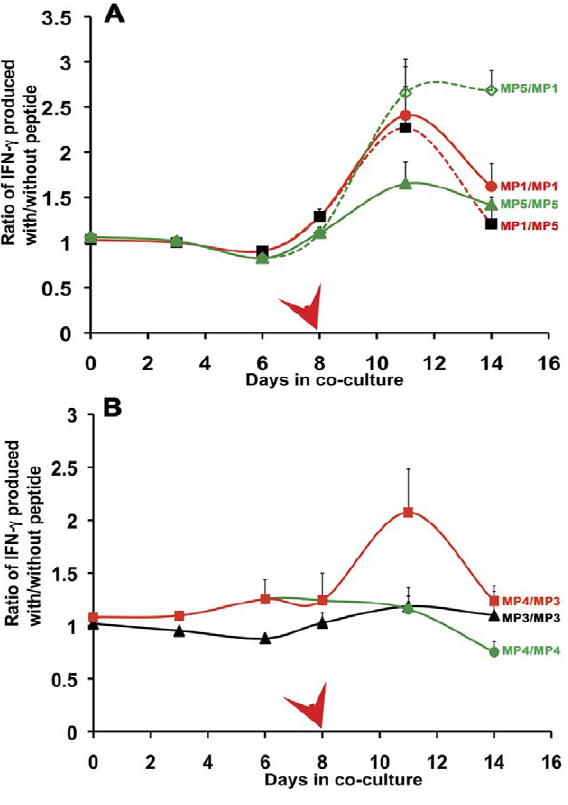
Figure 5. Cross-stimulation of CD14- cells by mimic peptides. CD14 2 cells were incubated with DCs loaded with mimic peptides and then re-stimulated with a fresh batch of DCs loaded with same or a different mimic peptide. T-cell stimulation was monitored by quanti- fying the amount of IFN- c released into the medium. The IFN- c levels were normalized to the levels produced following incubation with DCs that had no peptides loaded. Error bars represent the normalized % error from two independent experiments. The combination of peptides N are indicated in the figure and are as follows A. MP1 followed by MP1; ), MP1 followed by MP5; red dashed line ( & ), MP5 red solid line ( followed by MP5; green solid line ( m ) and MP5 followed by MP1; green N dashed line ( e ). B. MP3 followed by MP3; black solid line ( m ), MP4 ), MP4 followed by MP3; red solid followed by MP4; green solid line ( line ( & ).